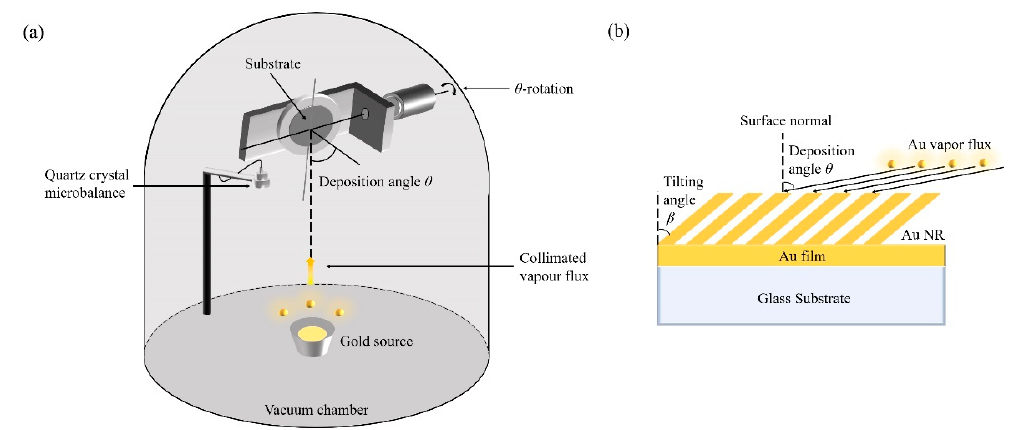
Figure 2. ( a ) The schematic of the Oblique Angle Deposition (OAD) process. ( b ) The schematic of the AuNRs structure. The definition of the deposition angle θ and the tilting angle β is shown.